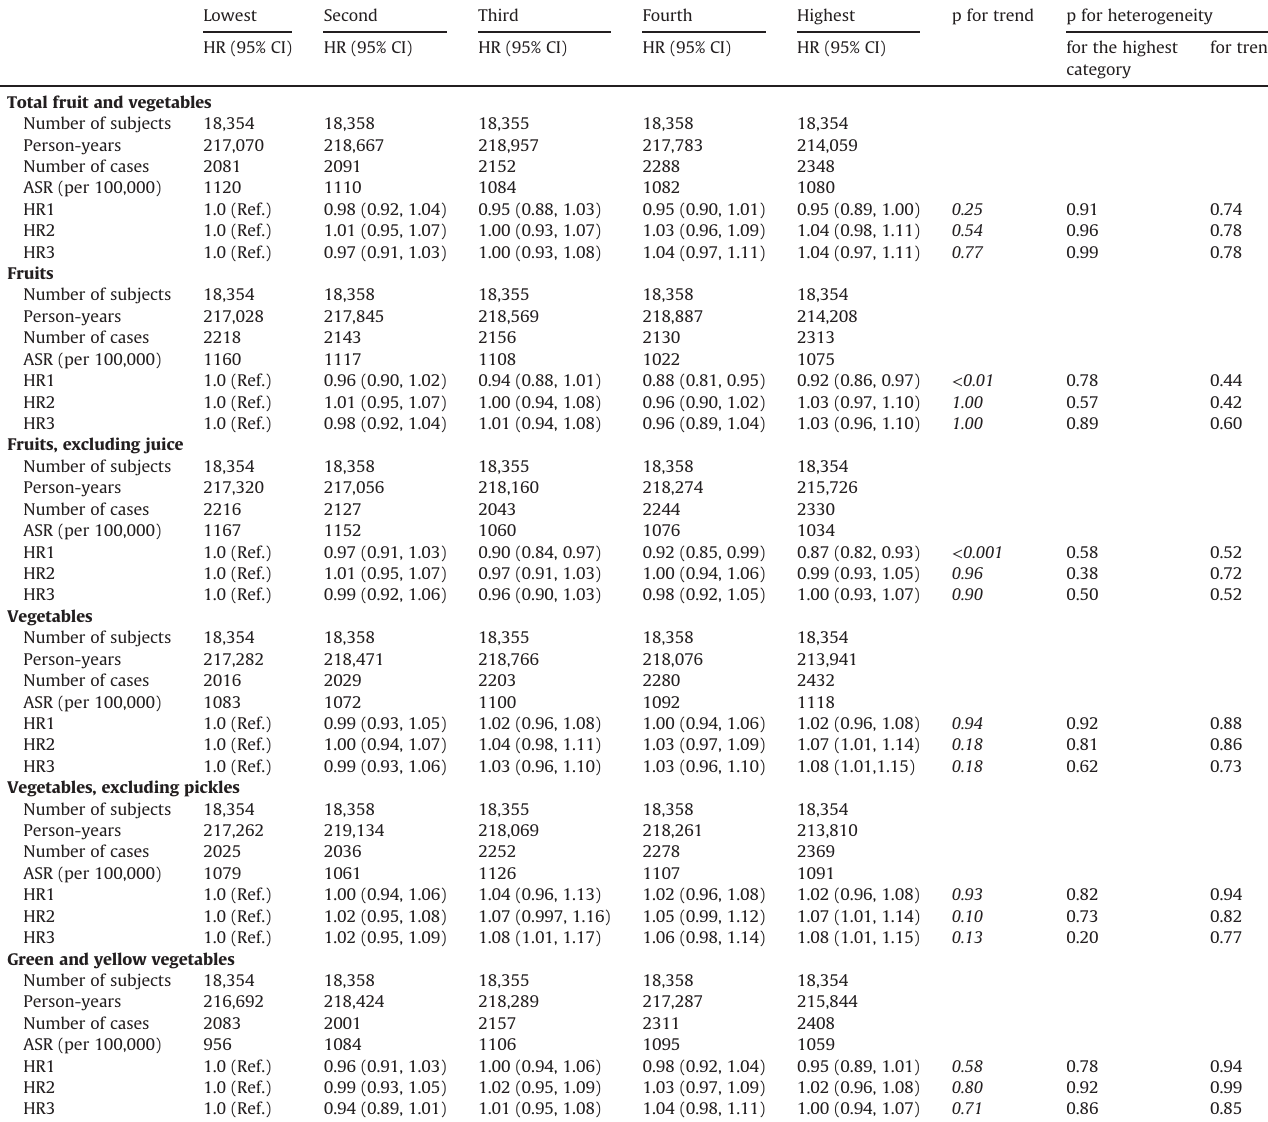
Table 2-1 Pooled analysis of overall cancer incidence according to quintile of fruit and vegetable consumption in Japanese men, 1990 e 2006. Third Fourth Highest p for